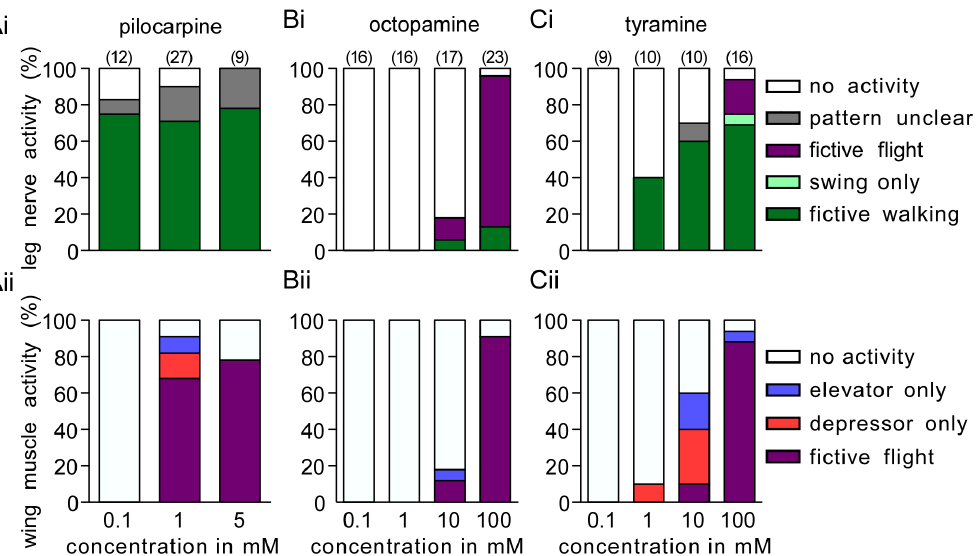
Figure 4. Bar charts giving the concentration dependent occurrence (%) of different types of motor activity evoked by: A pilocarpine, B octopamine, C tyramine in leg nerves (i upper charts) and wing muscles (ii lower charts). Key (leg nerves): white bars: no activity; grey bars: pattern unclear; purple bars: fictive flight; light green bars: swing phase only; dark green bars: fictive walking. Key (wing muscles): white bars: no activity; blue bars: elevator only; red bars: depressor only, purple bars: fictive flight activity. Numbers in parenthesis give the number of preparations for each test group.